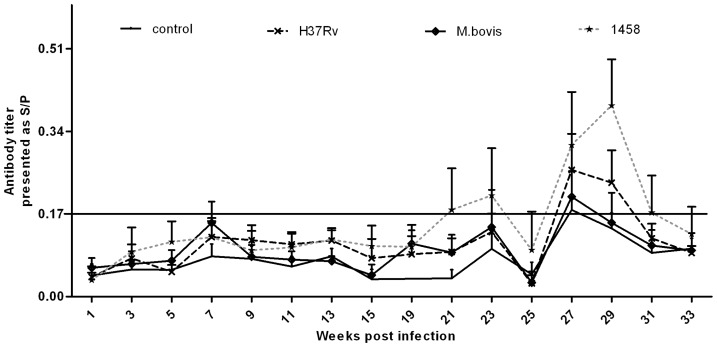
Experimental infection of calves with M. tbH37Rv, M.tb1458 of bovine origin, and M. bovis induced serum IgG production.The IgG concentrations, which were measured by indirect ELISA and expressed as OD630 values, apparently increased at the late stage of infection and were maintained for short time (weeks 28–29). The OD630 values at each timepoint were presented as mean ± SEM.